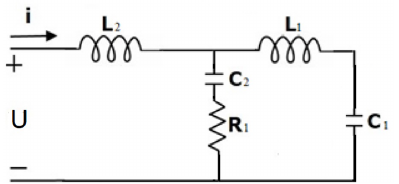
Figure 1. Example of a 2 degrees of freedom mechanical cascade model. Masses are denoted by m i , springs by k i , dampers by b i and external forces by F i .